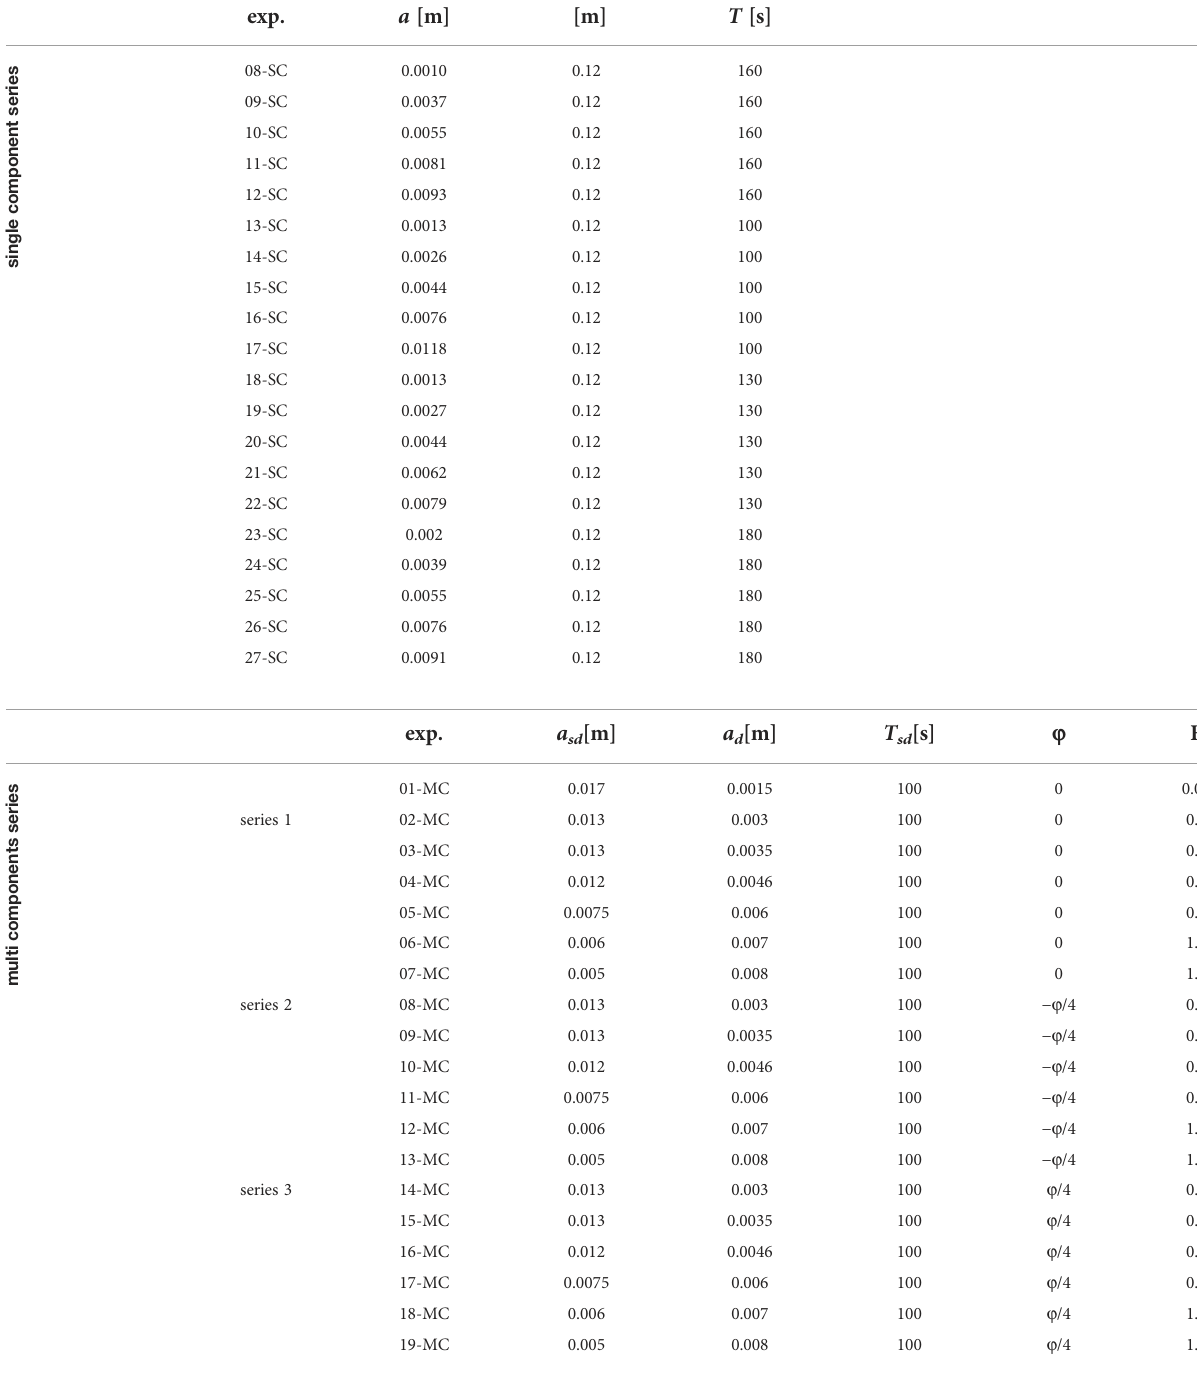
TABLE 1 Main experimental parameters. SC refers to the single component cases and MC to the multi components series of experiments. For the single component experiments, 7 preliminary runs were performed with the aim to tune the PIV system whereby they are not reported in the table. exp. a